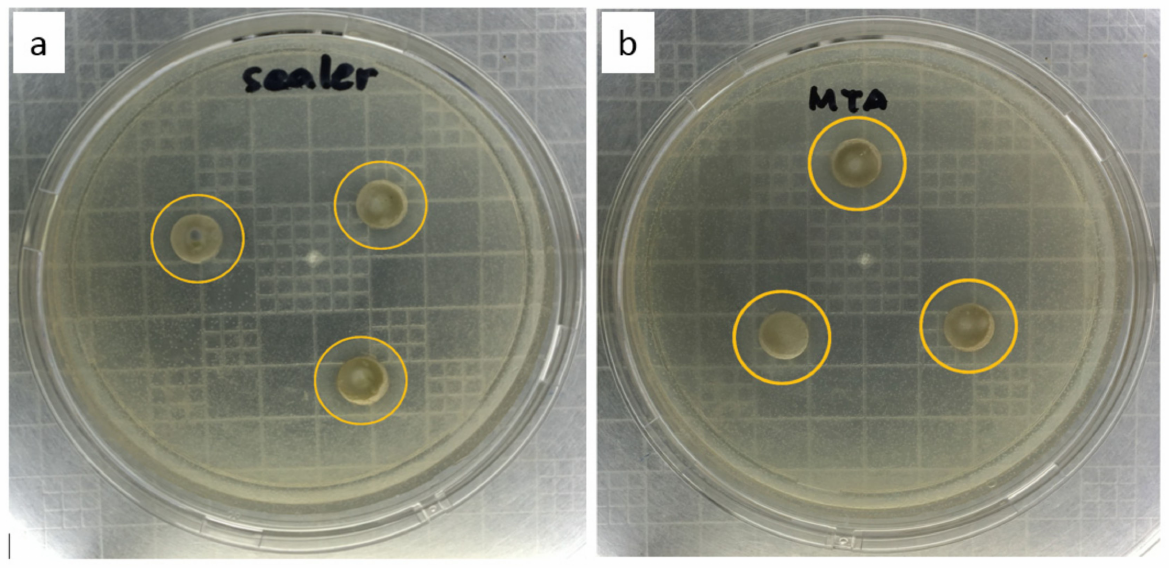
Figure 3. Bacterial inhibition zone (yellow circle) of ( a ) TS-WPC and ( b ) MTA samples against E.